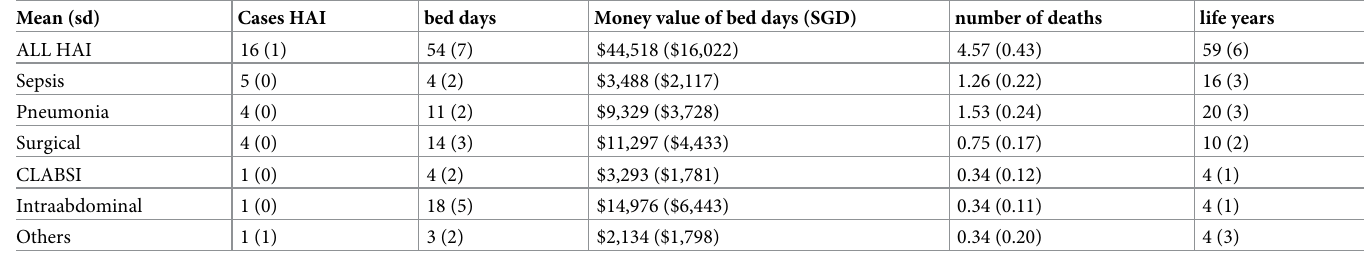
Table 4. Changes to outcomes with 1% effectiveness